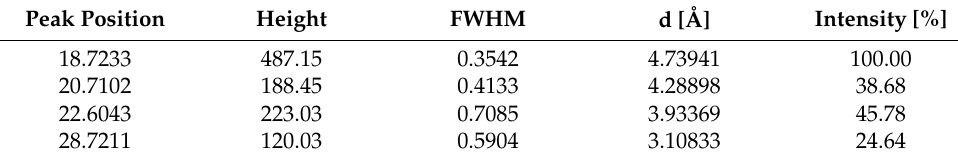
Table 4. Basic diffraction spectral parameters of PEEK ‐ 3.